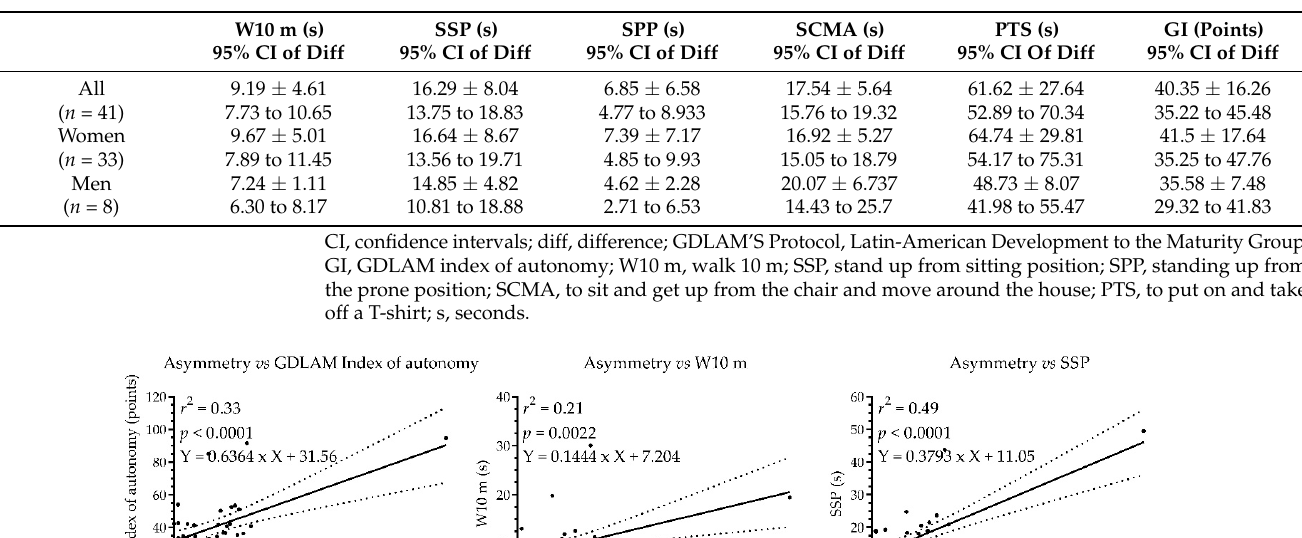
Figure 2. Asymmetries for the lower ( A ) and upper ( B ) limbs. Table 2. Results of the GDLAM’S Protocol in older adults.